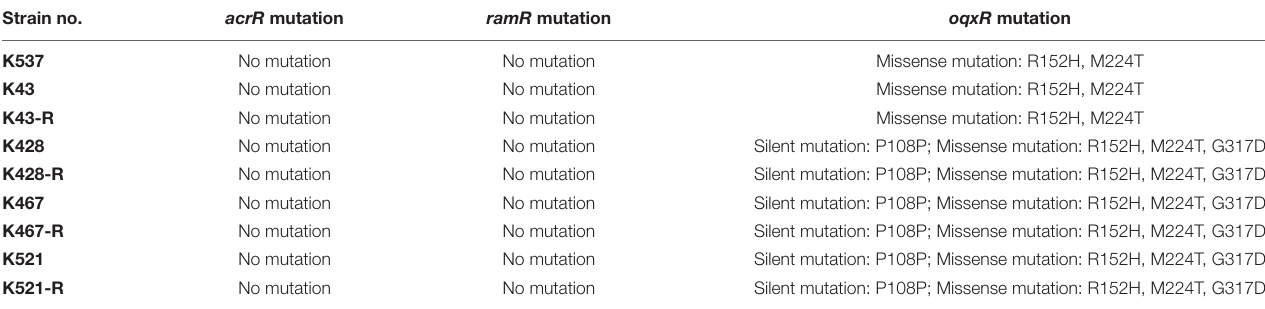
TABLE 2 | Mutations of acrR , ramR and oqxR in five clinical isolates and four resistance-induced descendant strains. Strain